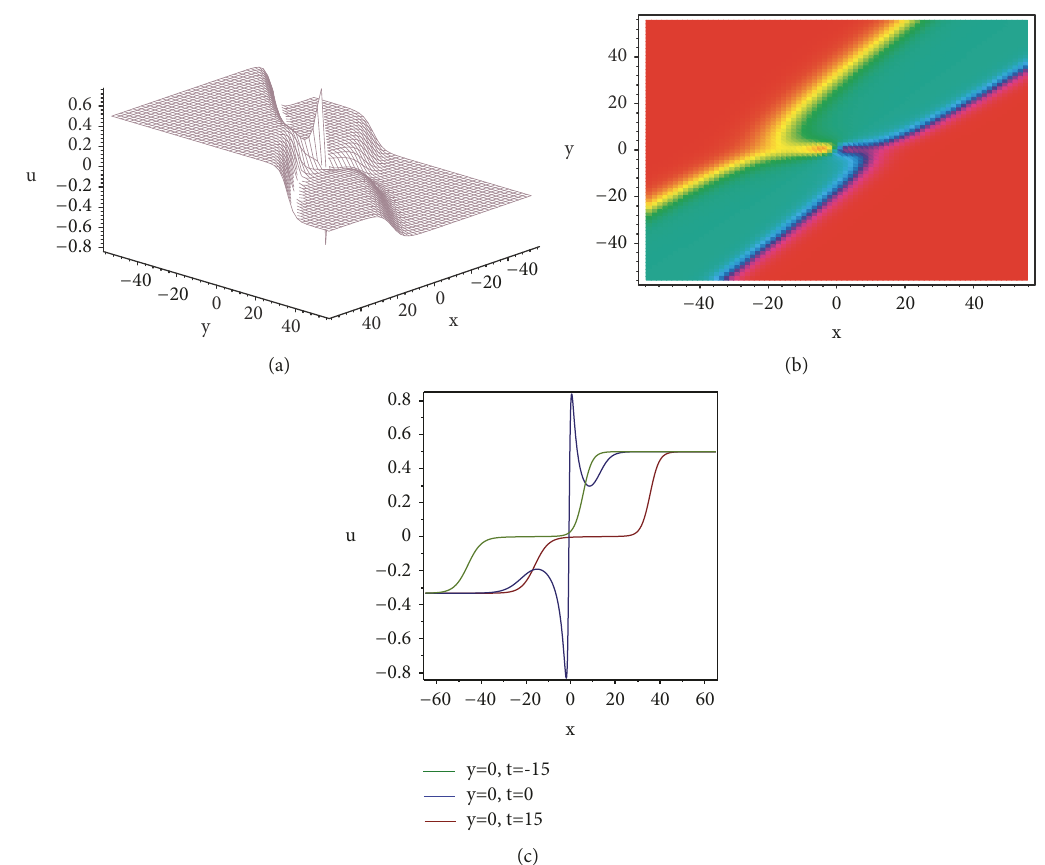
Figure 1: Profile of the interactionbetween alump waveand two-kink soliton in (22). (a) 3-dimensional plot with 𝑡 = 0 , (b)the corresponding density plot, and (c) the curve plot with various values of